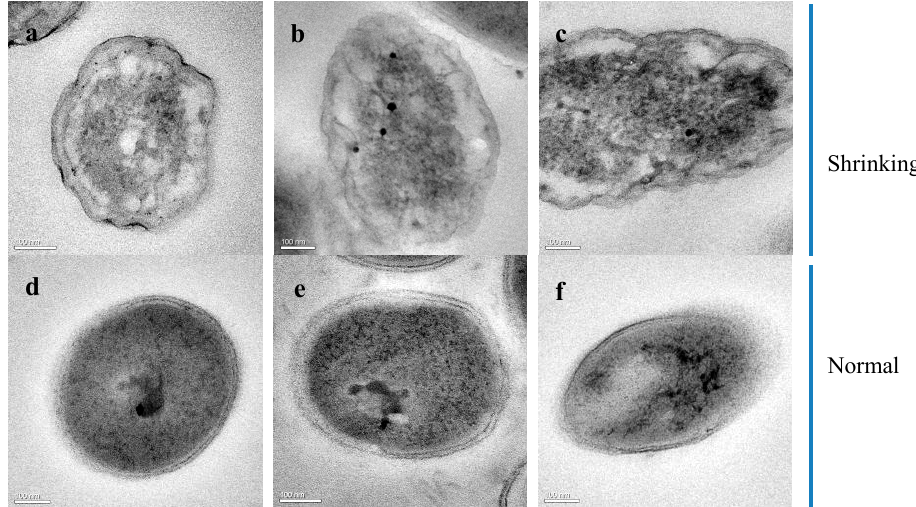
Figure 9. Shrinking and normal S. epidermidis Y2 cells as analyzed by HRTEM. ( a – c ) Shrinking cells of S. epidermidis Y2; ( d – f ) Normal cells of S. epidermidis Y2.